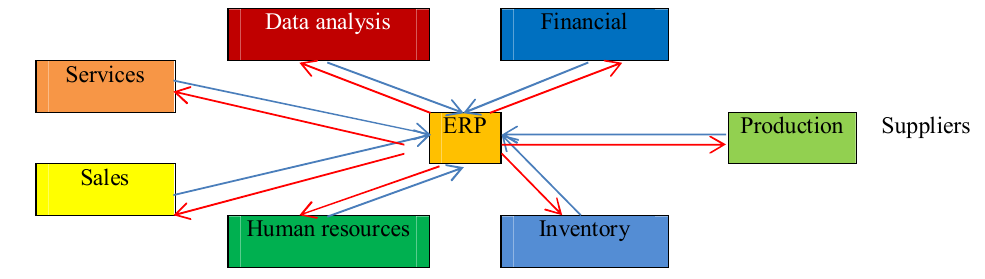
Fig. 1. The concept and role of enterprise resource planning